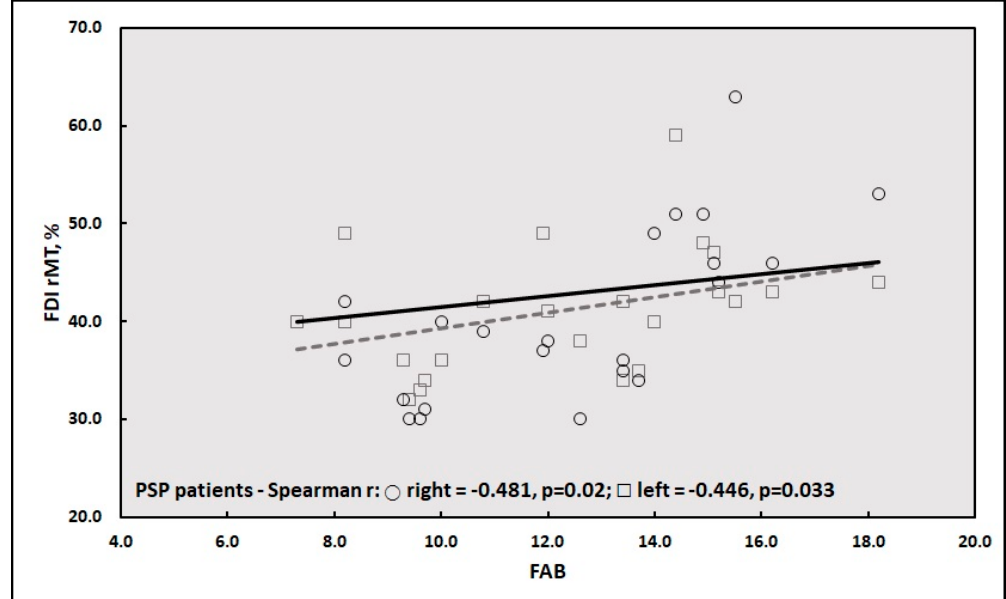
Figure 1. Correlation between FAB score and rMT from the left and right FDI muscles in PSP patients. Legend (in alphabetical order): FAB: Frontal Assessment Battery; FDI: First Dorsal Interosseous; PSP: Progressive Supranuclear Palsy; rMT: resting motor threshold; lines: linear regression lines.